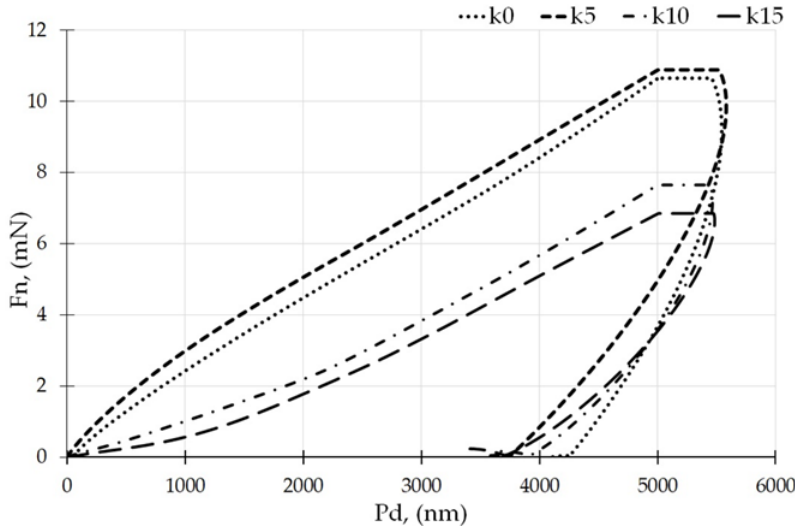
Figure 1. The representative curves of the force F n vs. the indentation depth P d .